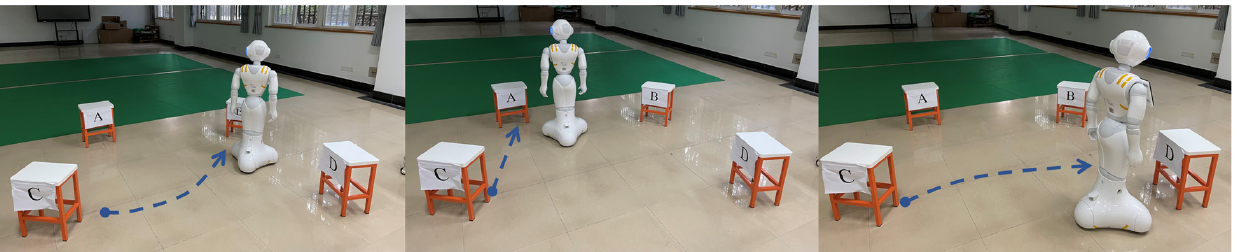
Figure 7. The process of robot navigation. Table 3. Preset parameters for each point.